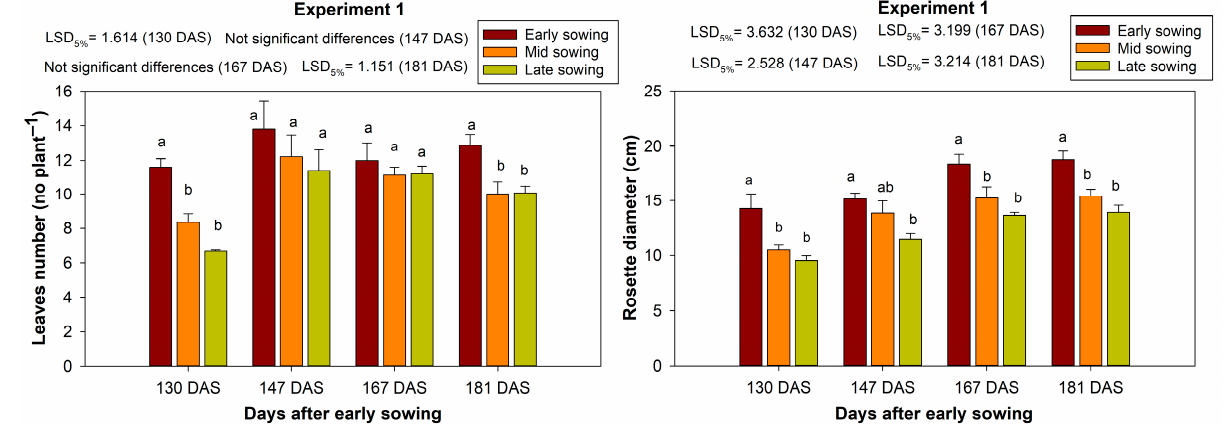
Figure 3. Leaf number (no plant − 1 ) and rosette diameter (cm) of bristly oxtongue as affected by the sowing date (early, mid, and late). For each sampling date, bars followed by the same letters were not shown to significantly differ with Fisher’s least significant difference (LSD) test. Error bars show the Standard Error values. Final measurement (source of variation: treatments): Leaf number: Fvalue = 31.155, p = 0.004, DF (degrees of freedom) = 2 and Rosette diameter: Fvalue = 9.305, p = 0.031, DF = 2.